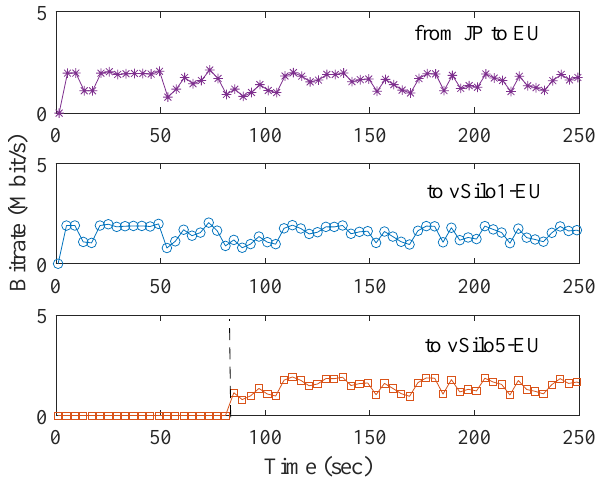
Figure 13. HTTP traffic during a live streaming